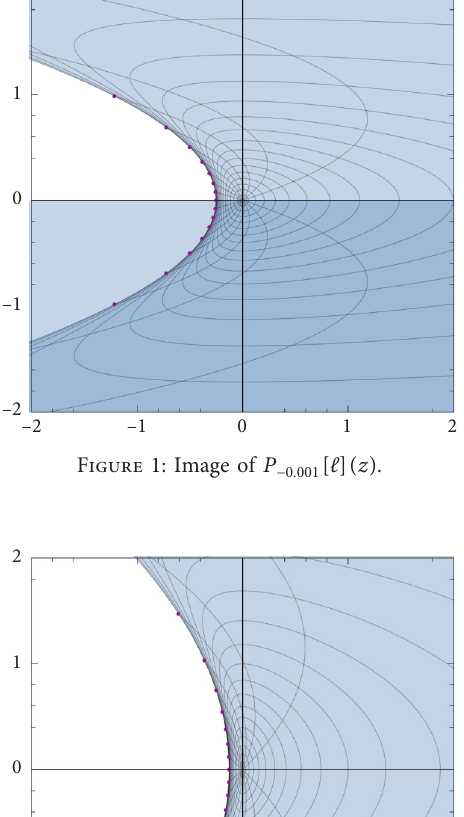
Figure 2: Image of P